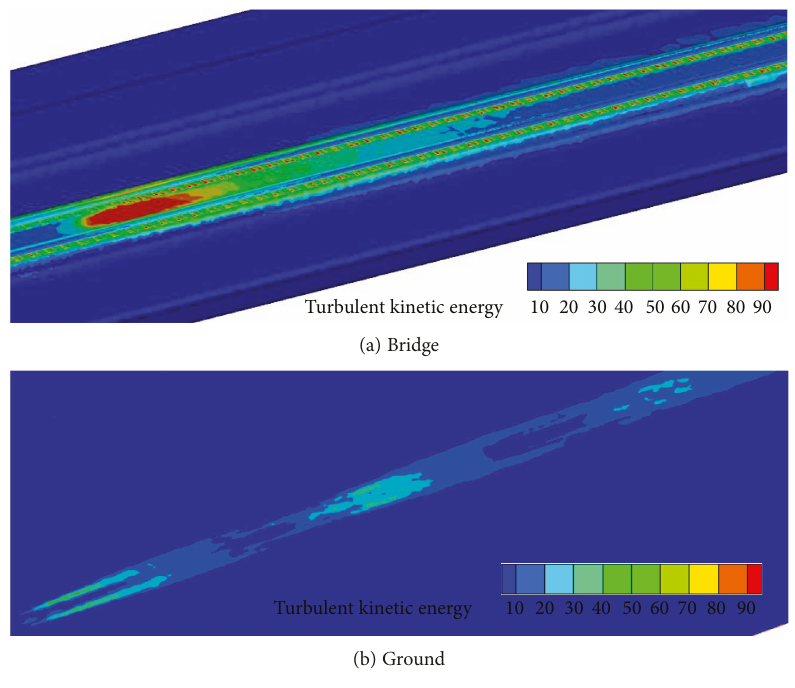
Figure 15: Comparison of turbulence energy under di ff erent road situations.